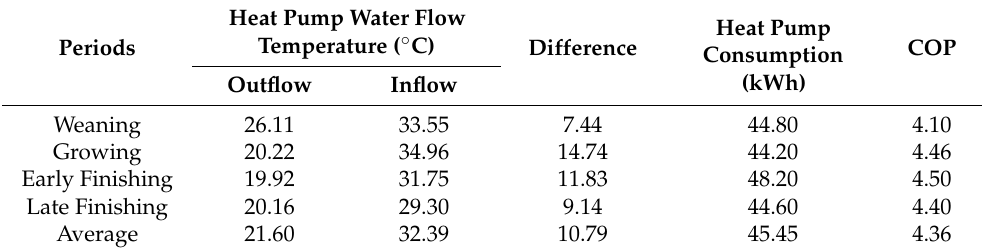
Table 3. Heat pump water flow temperature and the coefficient of performance (COP) of the GHP cooling